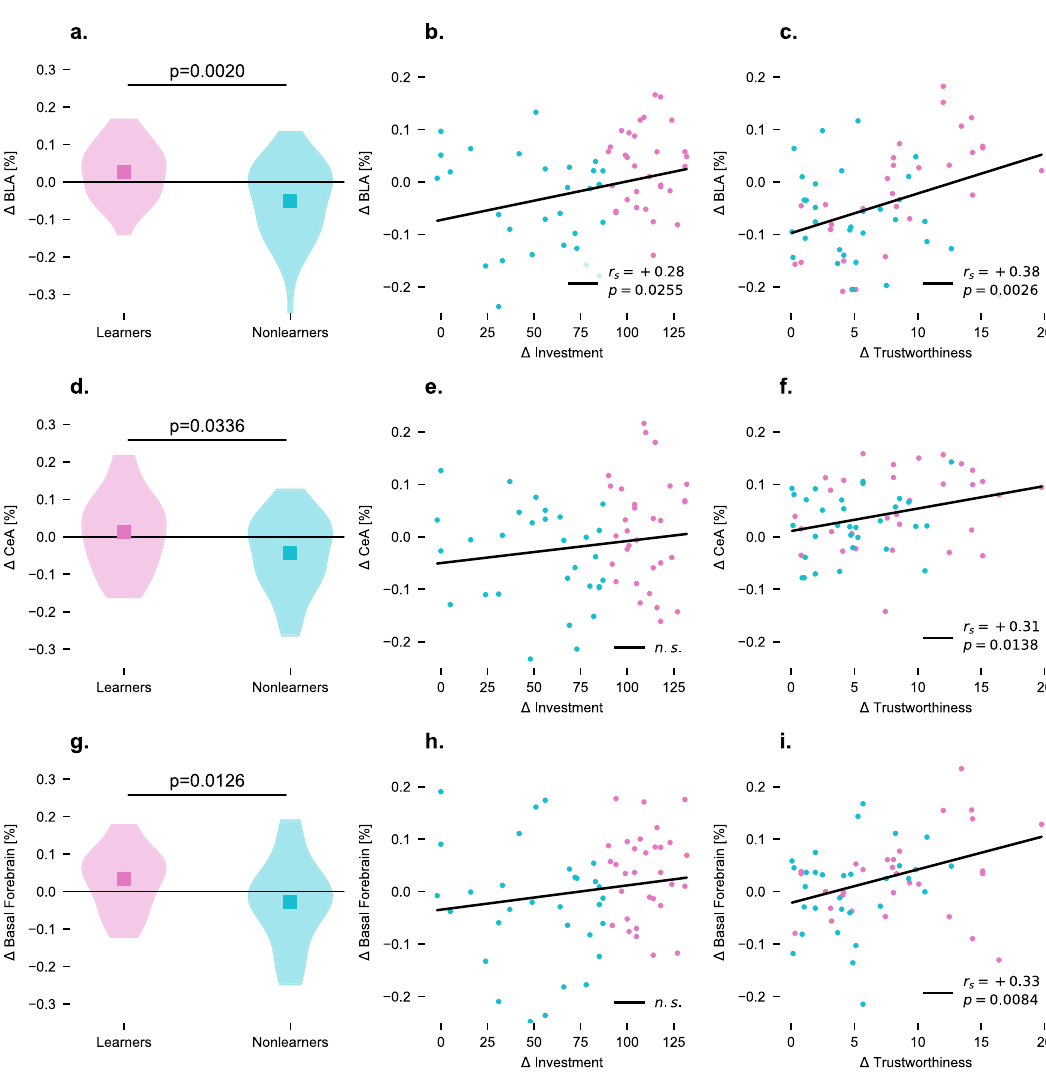
Fig. 3 Activation differences between untrustworthy and trustworthy player in the preparation phase. BLA activation differences (contrast: untrustworthy – trustworthy) were higher for learners (magenta) vs. non-learners (cyan) ( a ), correlated with investment differences ( b ) and post- experiment subjective trustworthiness rating differences ( c ). The same relationship was found for CeA ( d , f ), except the correlation with investment differences was not signi fi cant ( e ). An exploratory analysis of the basal forebrain showed a similar relationship ( g – i